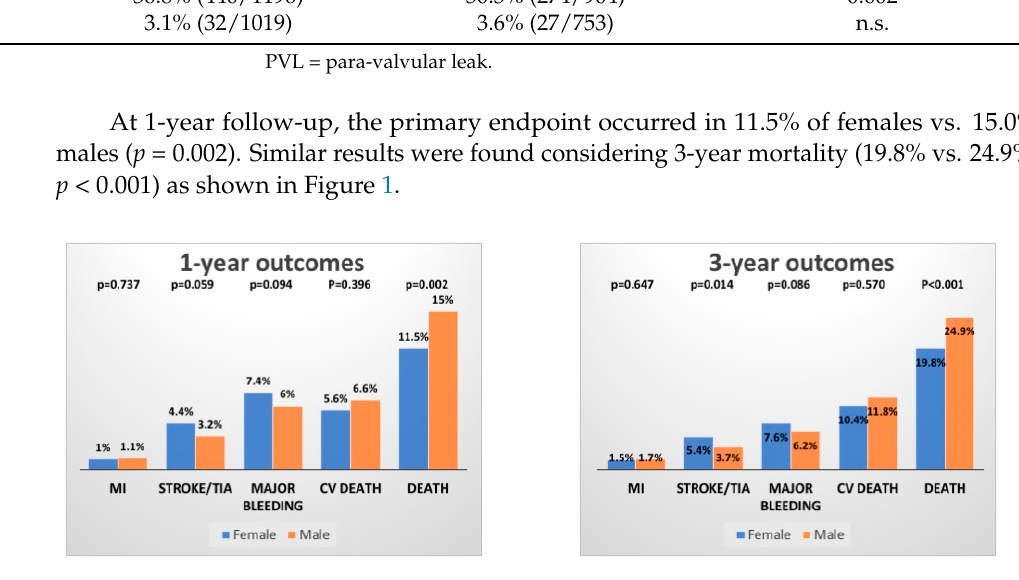
Figure 2. The 1-year and 3-year death in male and female, adjusted respectively for age, STS score, eGFR, diabetes and for age, STS score, eGFR, diabetes and severe COPD.